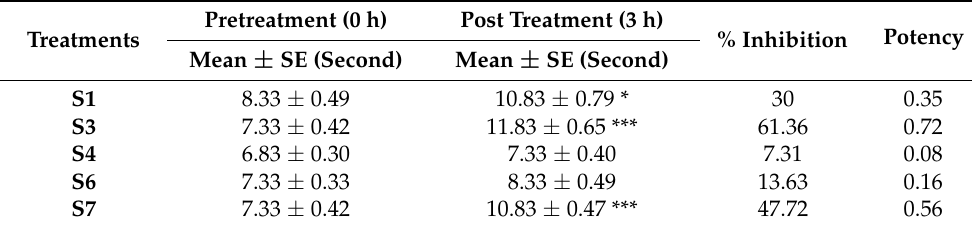
Table 2. Analgesic activities of selected